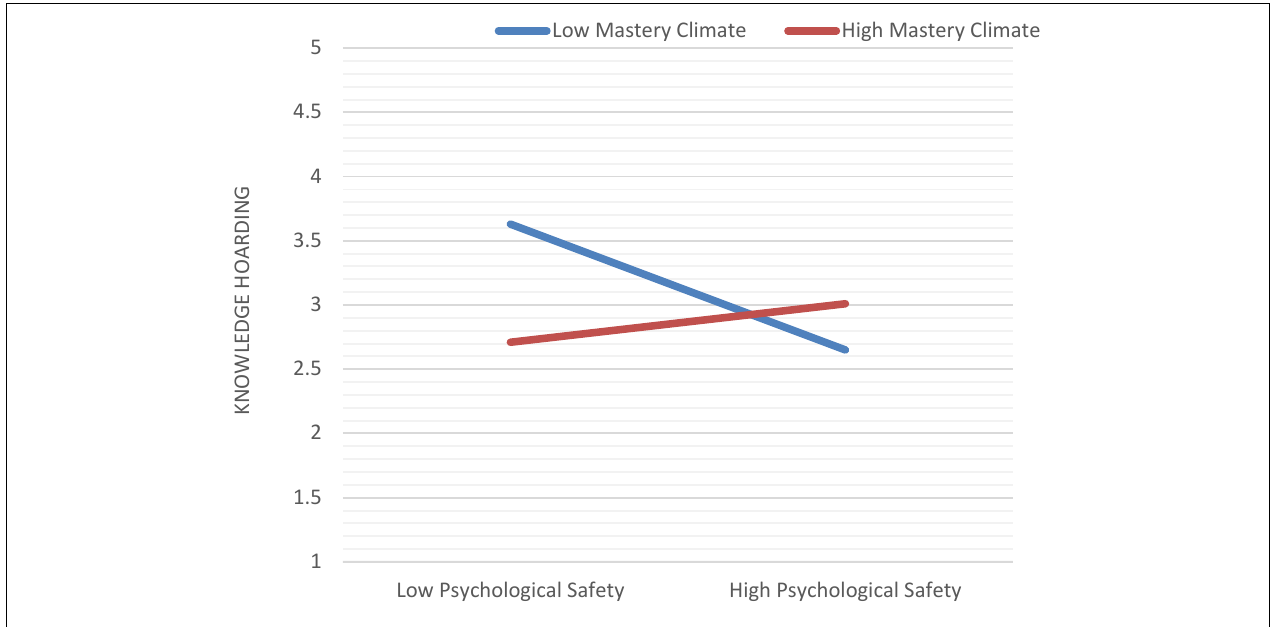
FIGURE 2 | Interaction